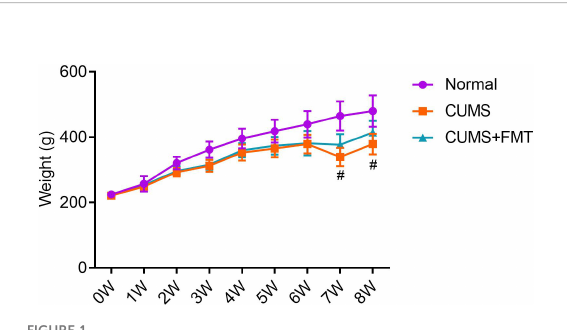
FIGURE 1 Mean weight of each experimental group throughout the study